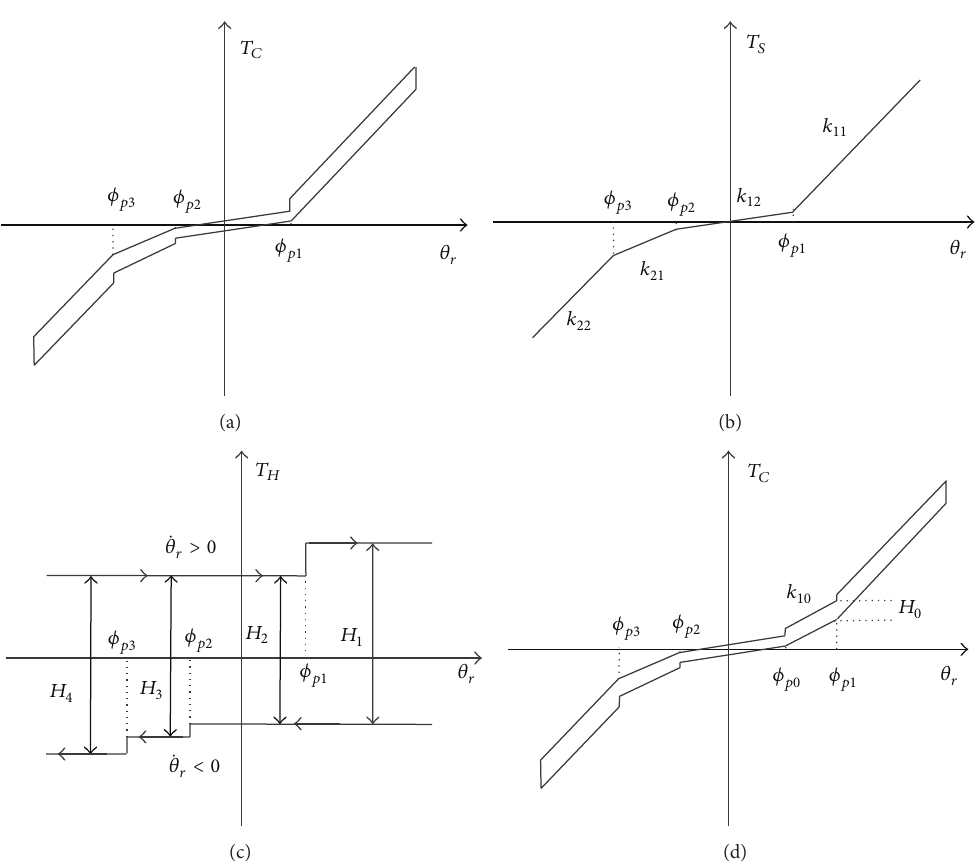
Figure 7: Nonlinear characteristics of a multistage clutch damper: (a) nonlinear characteristics of a two-stage clutch damper, (b) piecewise stiffness characteristics of the two-stage clutch damper, (c) piecewise hysteresis characteristics of the two-stage clutch damper, and (d) nonlinear characteristics of a three-stage clutch